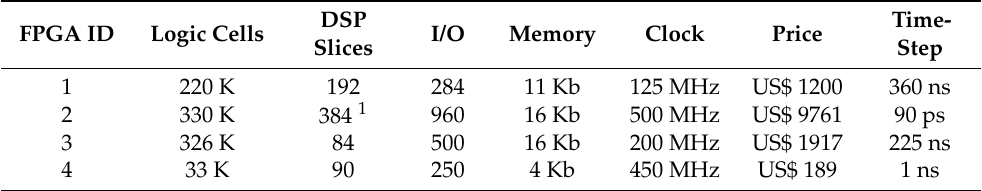
Table 4. FPGAs comparative